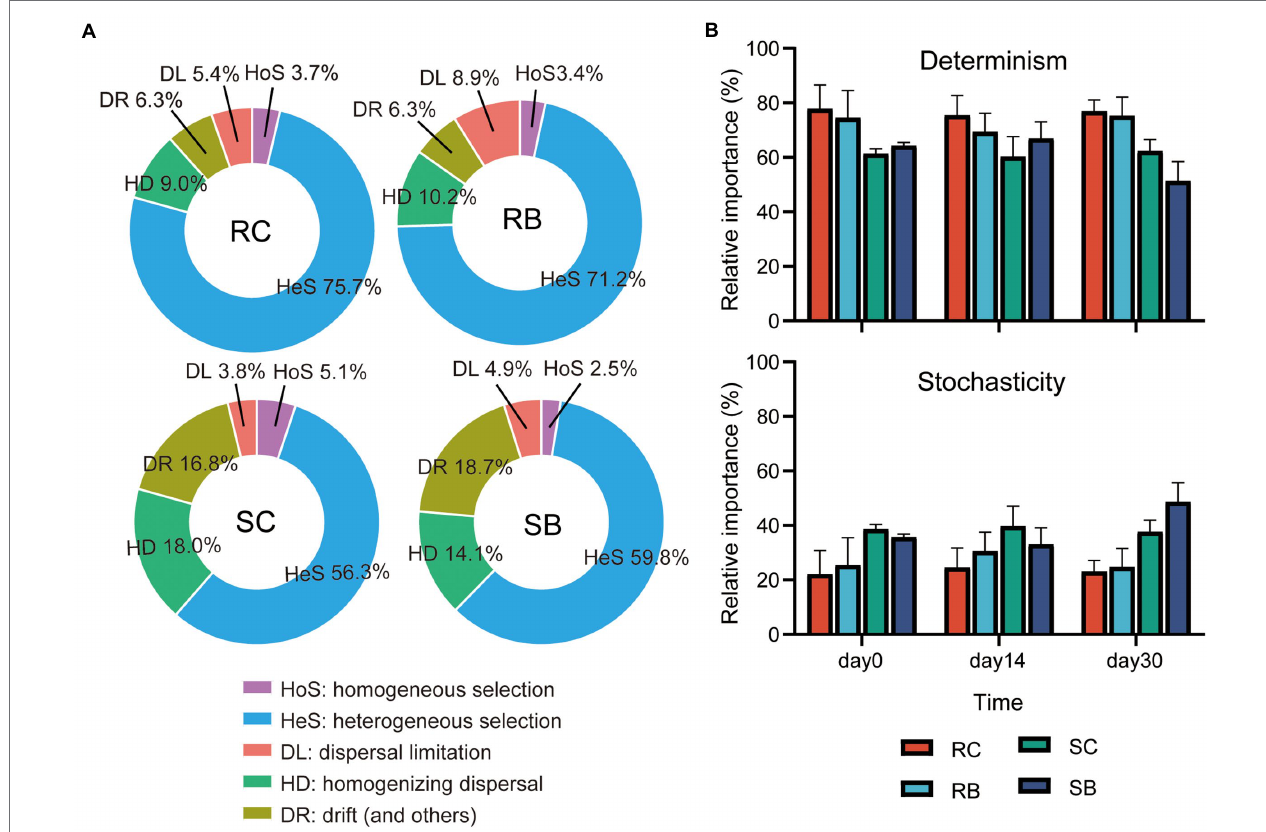
FIGURE 4 | Relative importance of different ecological processes in response to biochar addition. (A) Community assembly processes of bacterial community from different groups. (B) Changes of determinism and stochasticity; Data are presented as mean values ± SD. Error bars represented standard deviations; For RC, n = 6 comparisons among four biologically independent samples at each time point; For SC, RB and SB, n = 3 comparisons among three biologically independent samples at each time point. [Determinism: HoS + HeS; stochasticity: DL + HD + DR (Ning et al.,